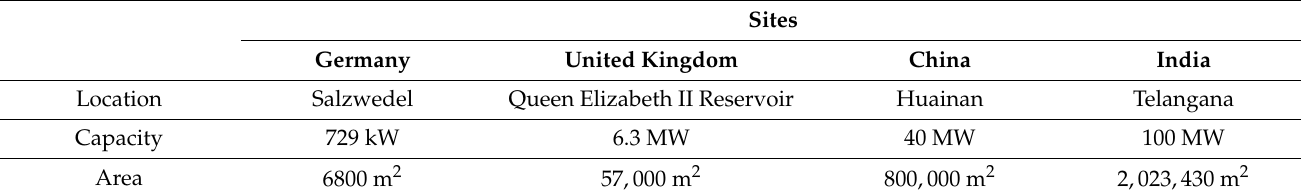
Table 4. The location of the four chosen sites.